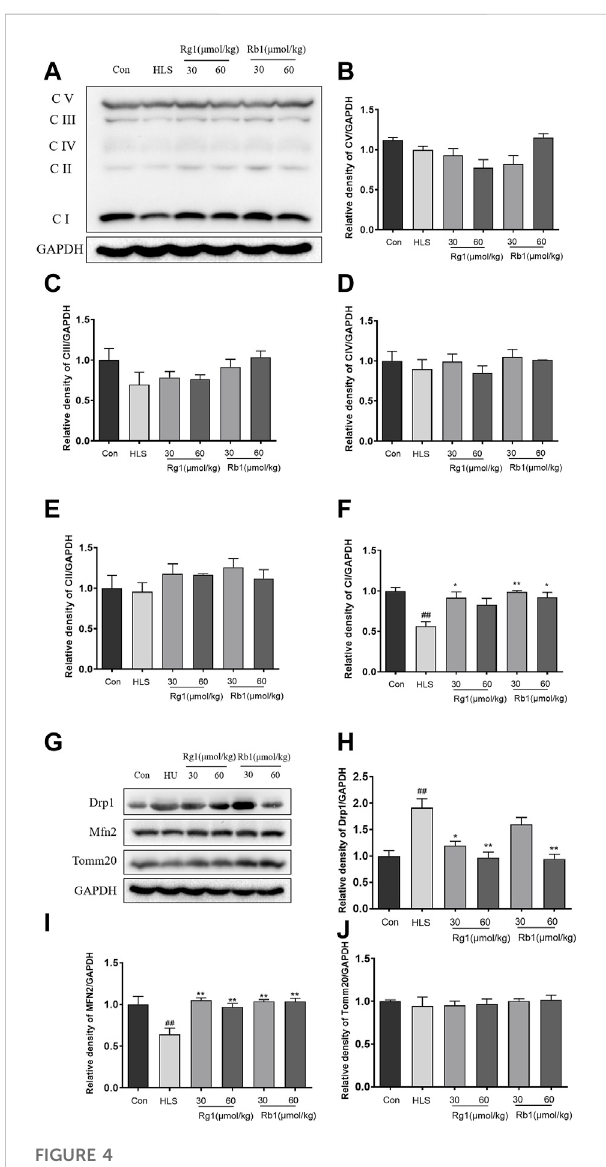
FIGURE 4 The effects of ginsenosides Rg1 and Rb1 on mitochondrial function of hindlimb suspension (HLS) rats. (A – F) Protein bands and relative expression levels of CV/GAPDH, CIII/GAPDH, CIV/GAPDH, C-II/GAPDH, and CV/GAPDH in the prefrontal cortex. (G – J) Protein bands and relative expression levels of MFN2 and Drp1. Data represent means ± SEM; N = 4 rats per group. # p < 0.05, ## p < 0.01, signi fi cantly different from control; * p < 0.05, ** p < 0.01, signi fi cantly different from HLS